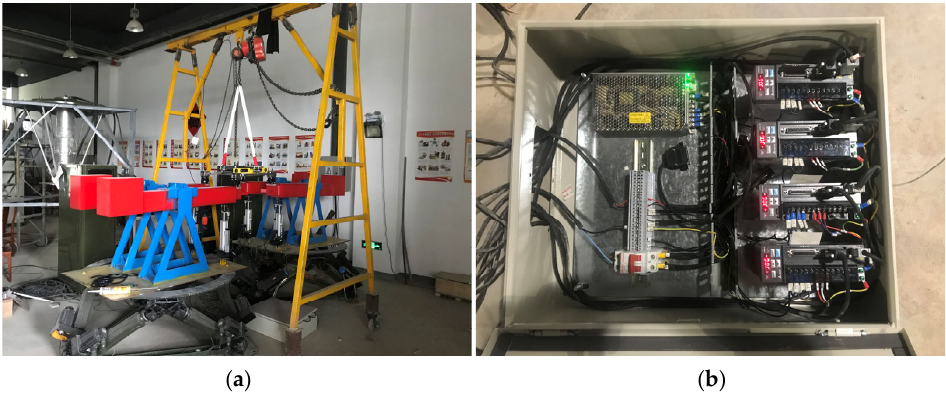
Figure 17. ( a ) Integrated Decommissioning Multi ‐ dimensional Vibration Hydrodynamic Test Bench and ( b ) Electric Control.